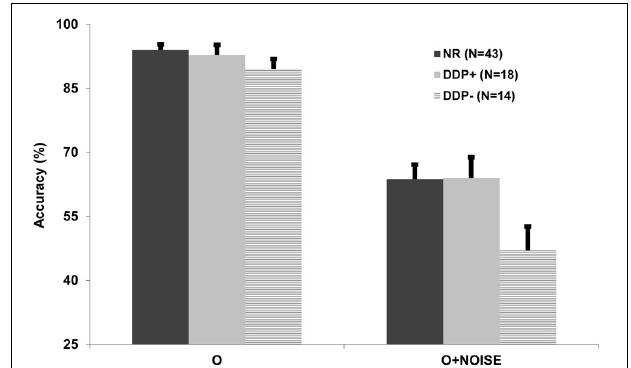
FIGURE 5 | Mean O and standard error as a function of group (NR, DDP + , and DDP − ), signal accuracy (O), and signal + noise accuracy (O + noise).